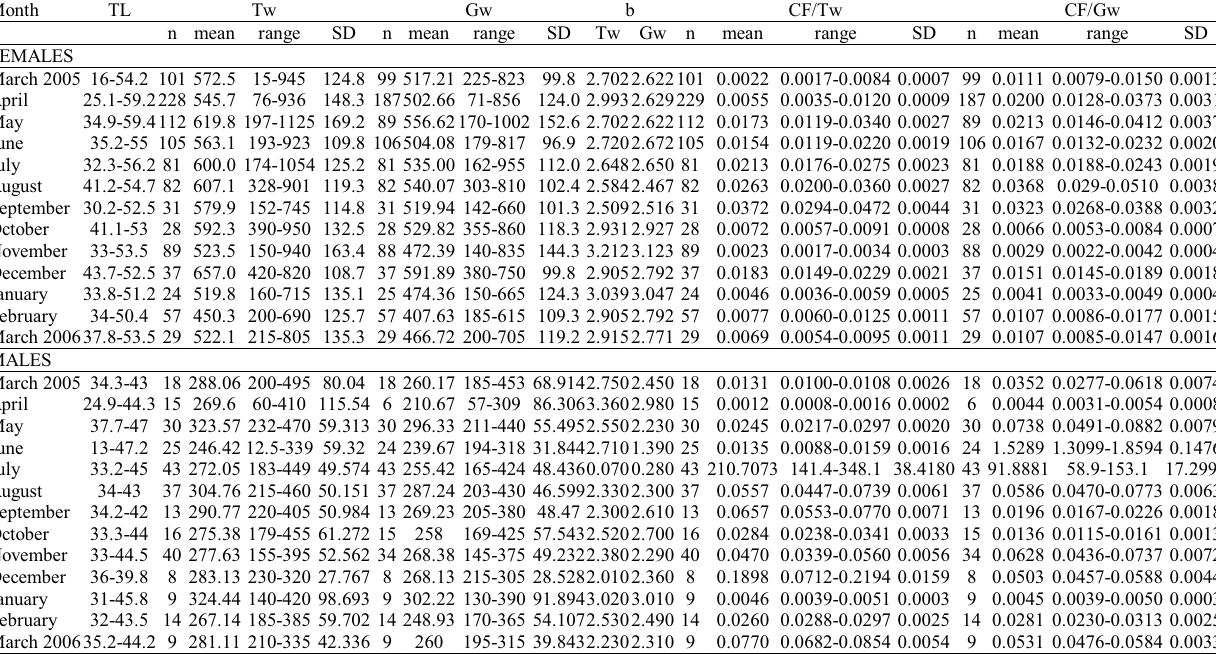
Table 5. Seasonal variation of the angular coefficient estimate (b) for males and females of Rioraja agassizi ; standard error of the regression total length-total/gutted weight, t b, correlation coefficient of the regression, d. f. =degrees of freedom and probability (p the theoretical value 3 and probability (p